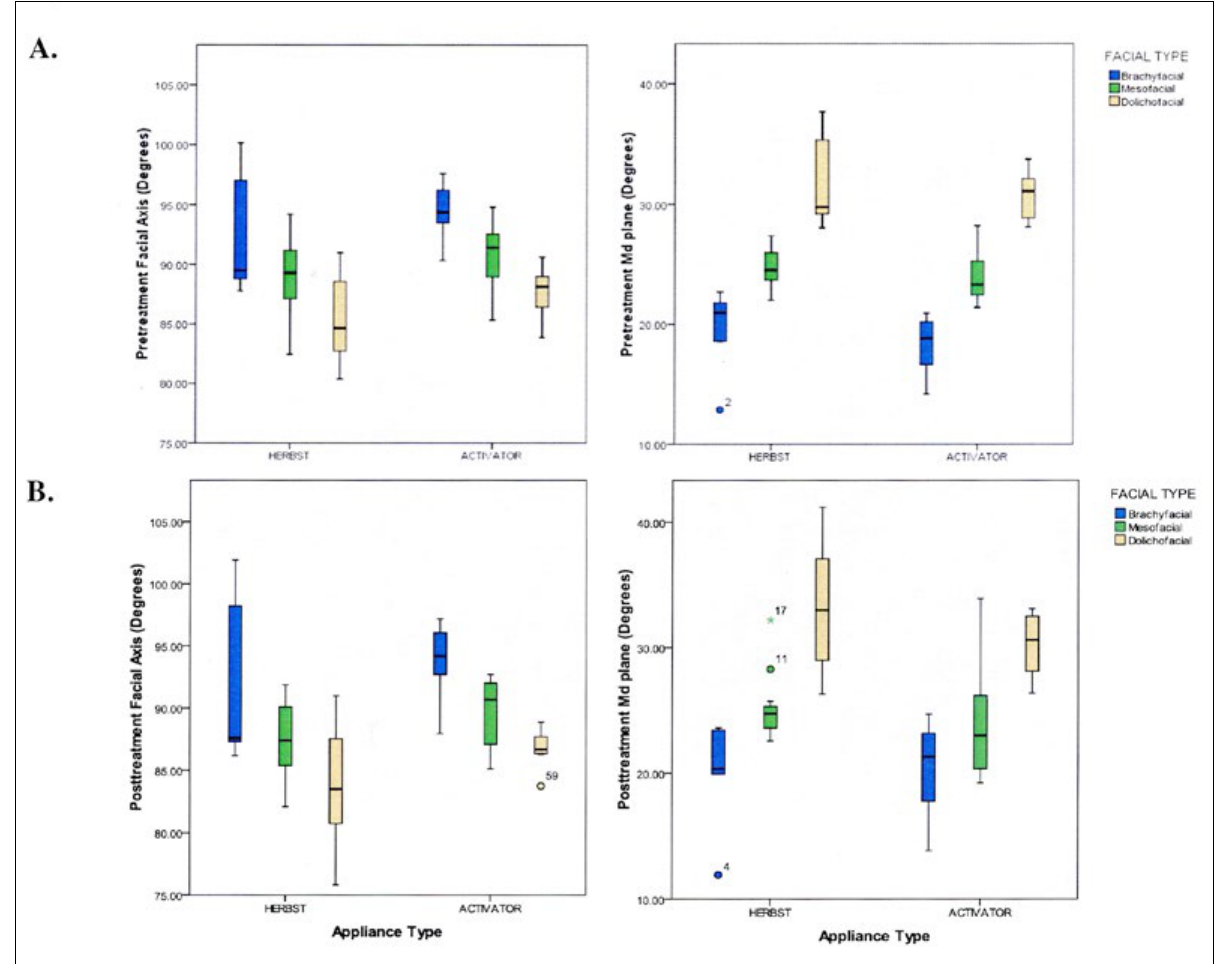
Figure 2. Facial axis and mandibular plane angle